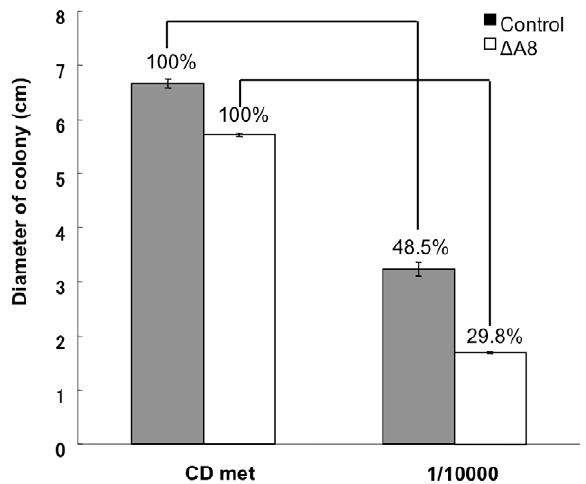
Figure 3. Autophagy supporting the mycelial growth. Wild-type and D Aoatg8 strains were inoculated and grown on either the CD medium with 0.15% methionine (nutrient-supplied) or its 10 4 times dilution (nutrient-depleted) for seven days. The colony diameters of each strain at the seventh day are shown. Relative diameters of each strain to the nutrient-supplied medium are shown as percentages. Error bars represent S. D. n=3.